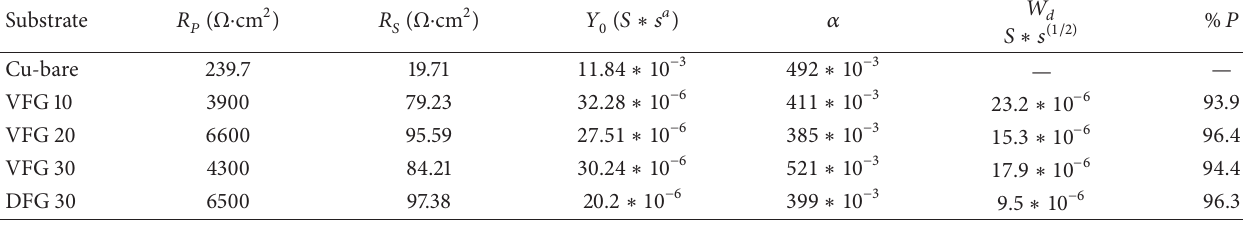
Table 1: Electrochemical parameters obtained from Nyquist plots of uncoated and coated copper alloy with superhydrophobic FG. Substrate